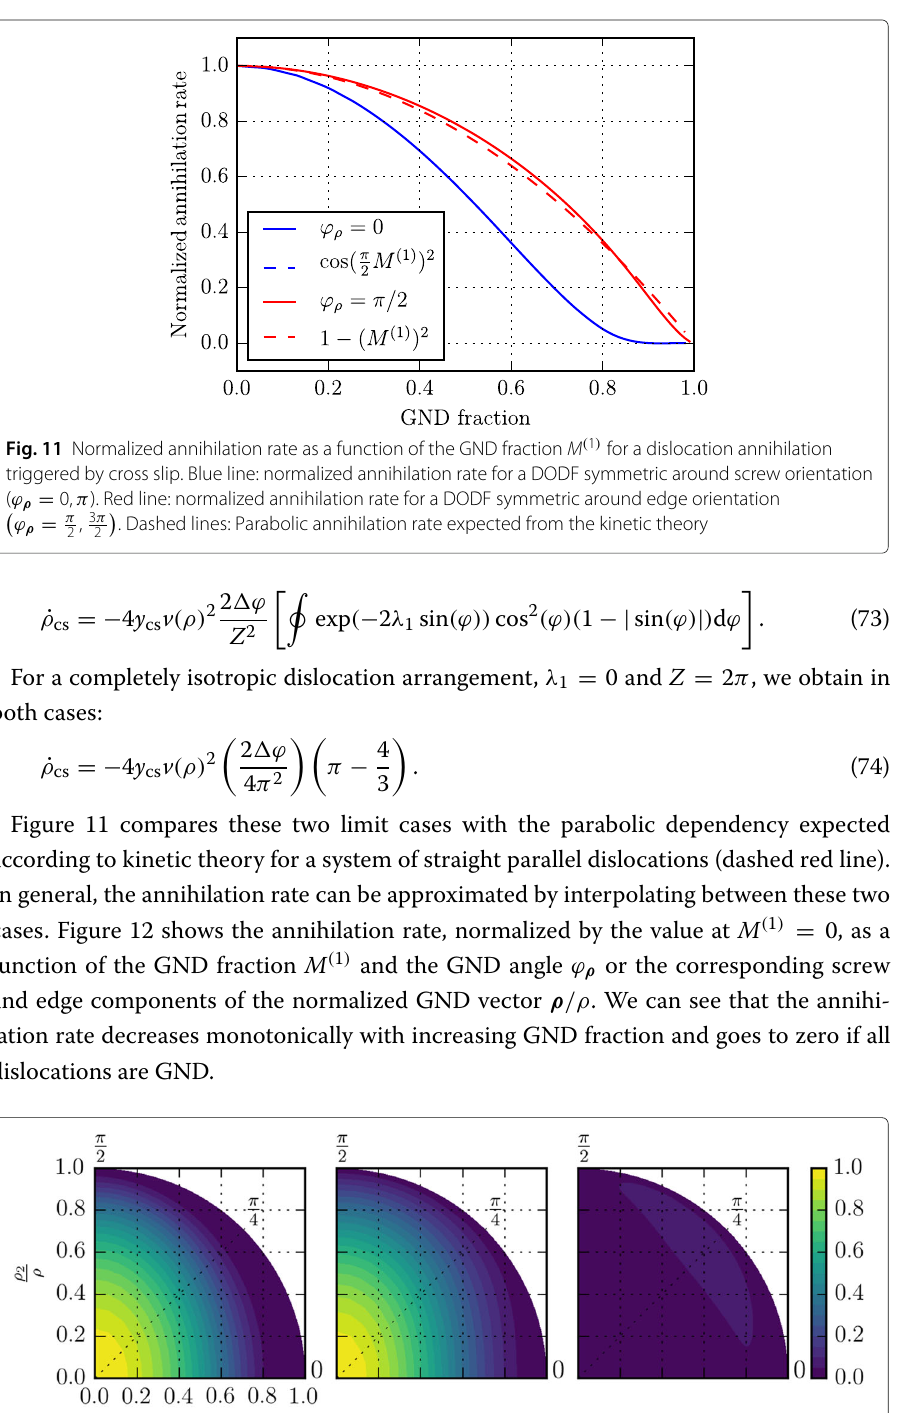
(cid:11) (cid:12) π | ρ | + ( (cid:8) ρ = ( (cid:8) ρ ) 2 cos 2 ) 2 cs 1 2 2 ρ